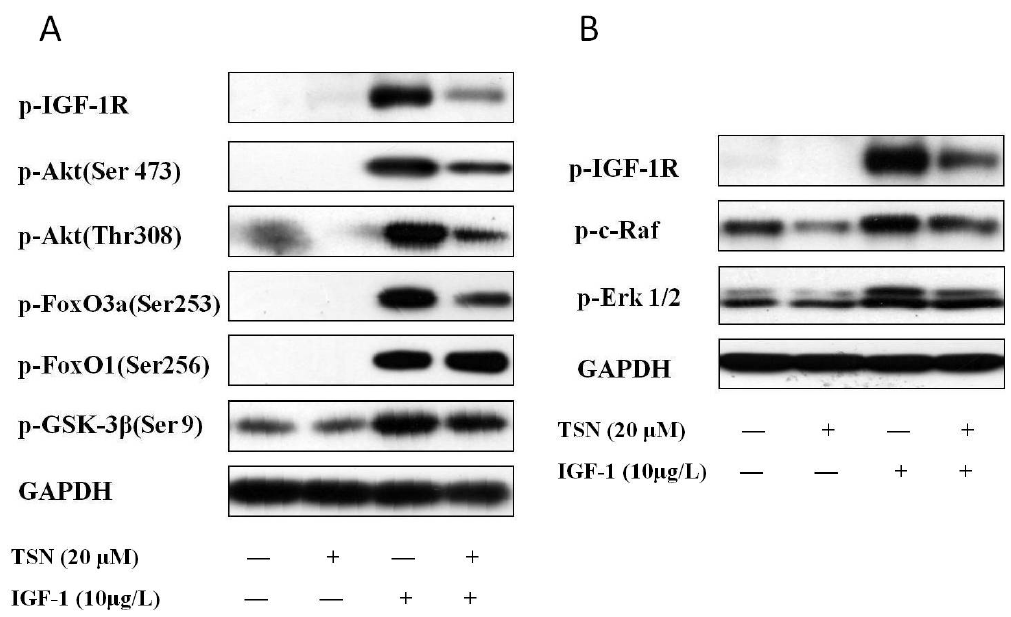
Figure 6. TSN inhibits IGF-1R mediated Akt and MEK signaling transduction. ( A ) PC12 cells were treated with 20 µM TSN and 10 µg/L IGF-1. The levels of p-IGF-1R, p-Akt, p-GSK-3β, p-FoxO3a and p-FoxO1 were determined by Western blotting; ( B ) PC12 cells were treated with 20 µM TSN and 10 µg/L IGF-1. The levels of p-c-Raf and p-ERK1/2 were determined by Western blotting.